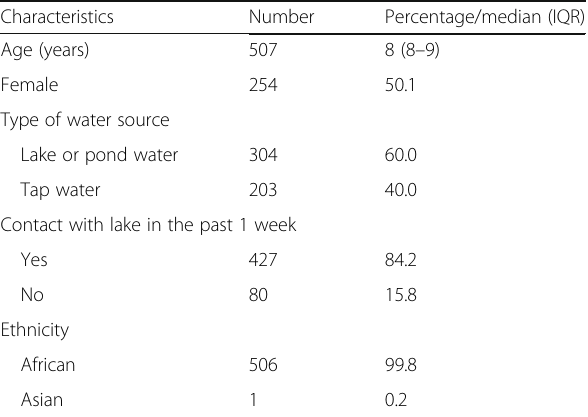
Table 1 Characteristics of 507 primary school children